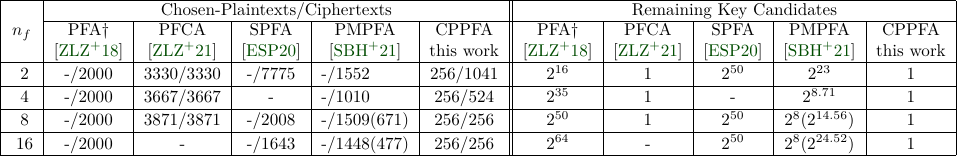
Table 1: The Table of Comparison with Related Works on AES-128( † : It is assumed the faults are known in advance) n